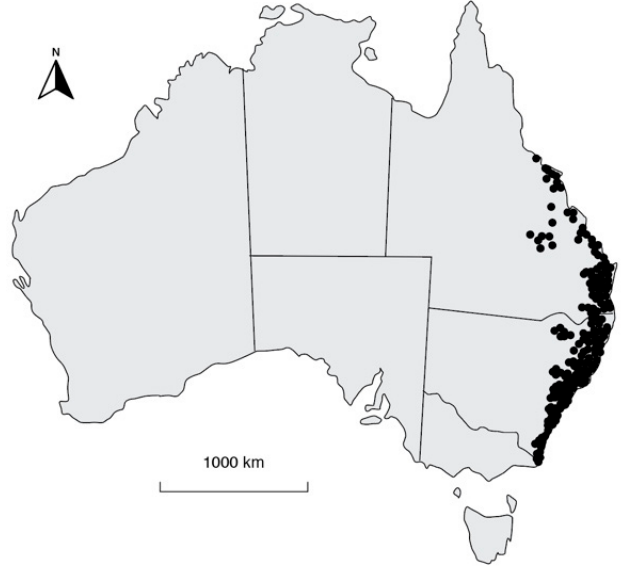
Figure 2. Distribution of Ficus coronata based on herbarium data. Vouchers from Western Australia (WA), Northern Territory (NT) and Far North Queensland (FNQ) were found to be in error and are not shown. Atlas of Living Australia (ALA) (2020) Ficus coronata occurrence records. Available at: ala.org.au, accessed on 30 May 2020).